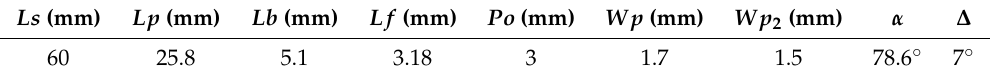
Table 1. Values of the Optimized design parameters for the antenna